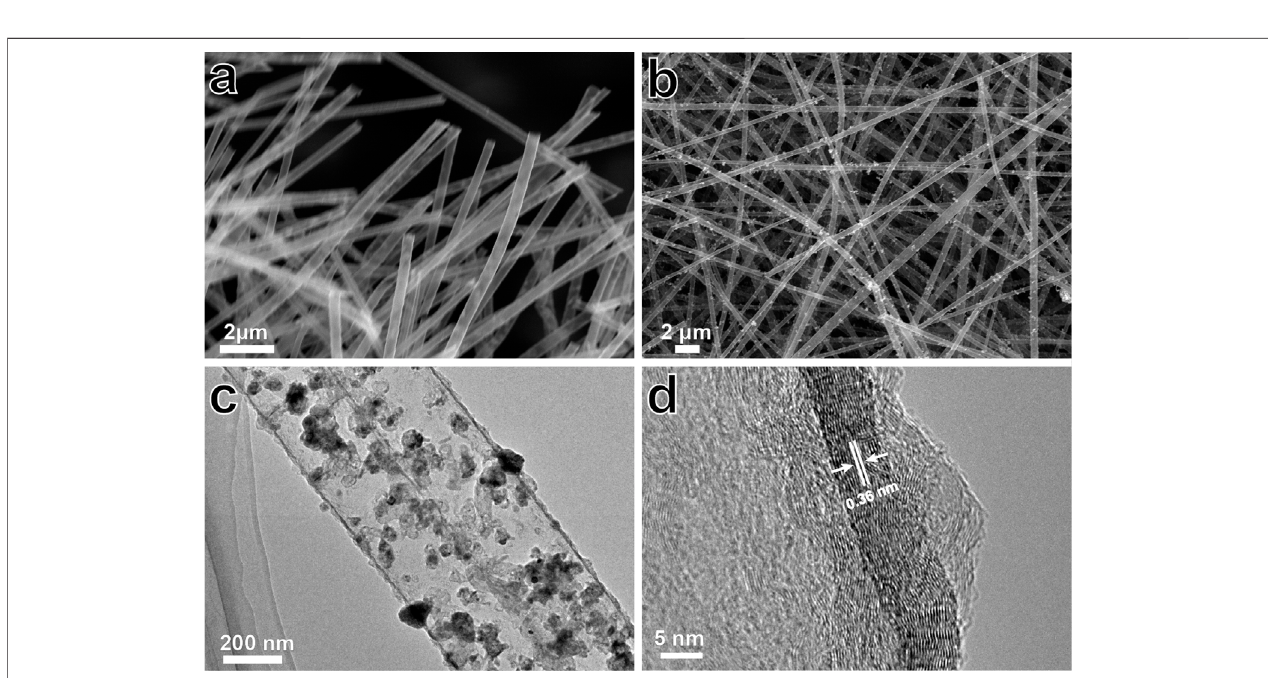
FIGURE 2 | SEM images of HCF (A) and Ni@HCF (B). (C and D) TEM images of